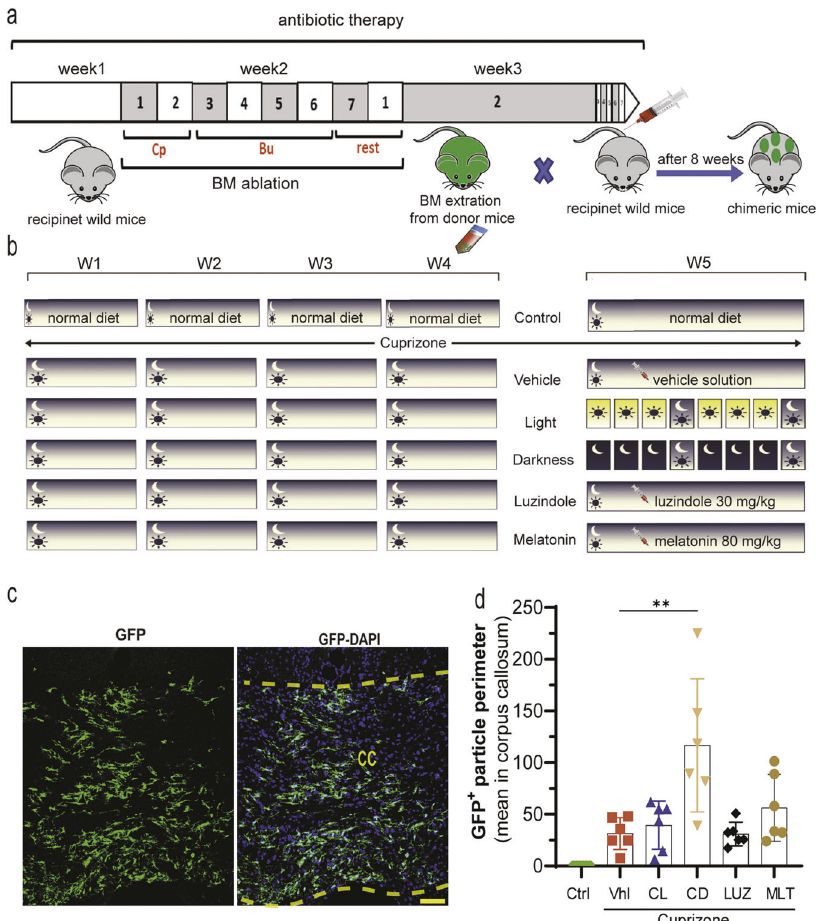
Fig. 7 The in fi ltration rate in the CNS. a Schematic illustration of establishing chimeric mice and ( b ) the protocol for the treatments in chimeric mice (antibiotic, Septra; Busulfan, Bu; Cyclophosphamide, Cp). c A representative example of GFP-tagged cells in fi ltrating the brain in the corpus callosum. d The corresponding quanti fi cations. ( n = 5 mice/group; 3 slides per mouse). Signi fi cance is indicated by ∗∗ p < 0.01, ∗∗∗ p < 0.001, and ∗∗∗∗ p < 0.0001. Scale bars, 20 μ